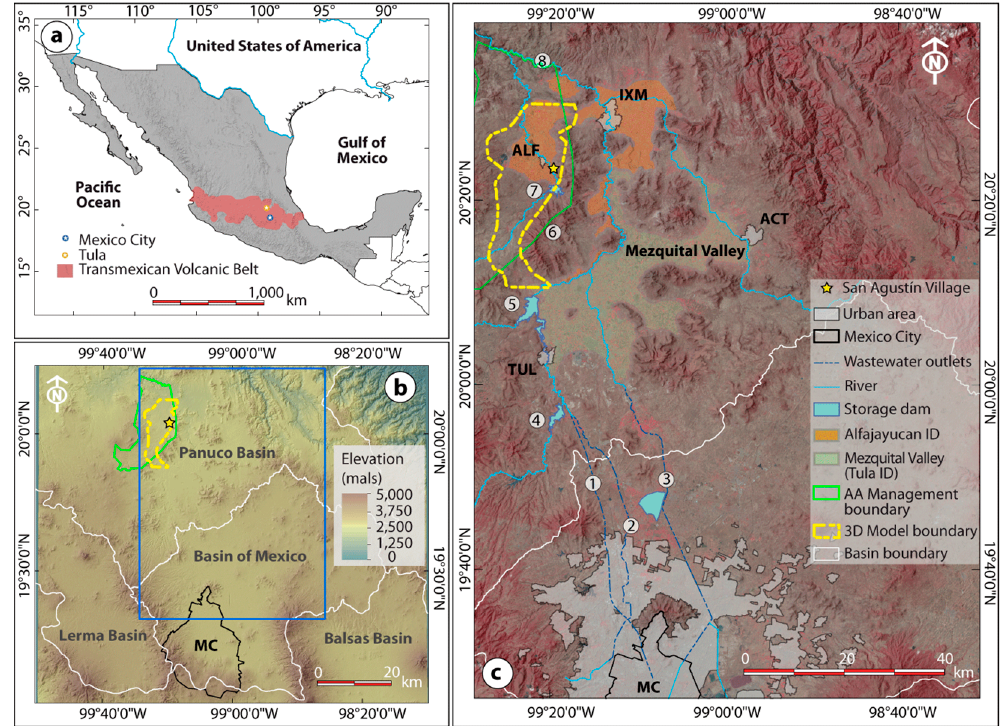
Figure 1. Geographical setting. ( a ) Mexico; ( b ) Mexico City (MC) and hydrologic watersheds; ( c ) study area. For part ( c ), MC: Mexico City, ACT: Actopan, TUL: Tula, IMX: Ixmiquilpan, ALF: Alfajayucan, ID: Irrigation District, AA: Alfajayucan aquifer (the management boundary is shown in green line, parts b and c ), (1) Central Emitter; (2) Western wastewater outlet; (3) Grand Canal; (4) Requena Dam; (5) Endhó Dam; (6) Zinthe Mountain Range; (7) Rojo Gómez Dam; (8) Tula River. Note that the 3D Model boundary (yellow line in parts b and c ) is shown in Section 3.6.